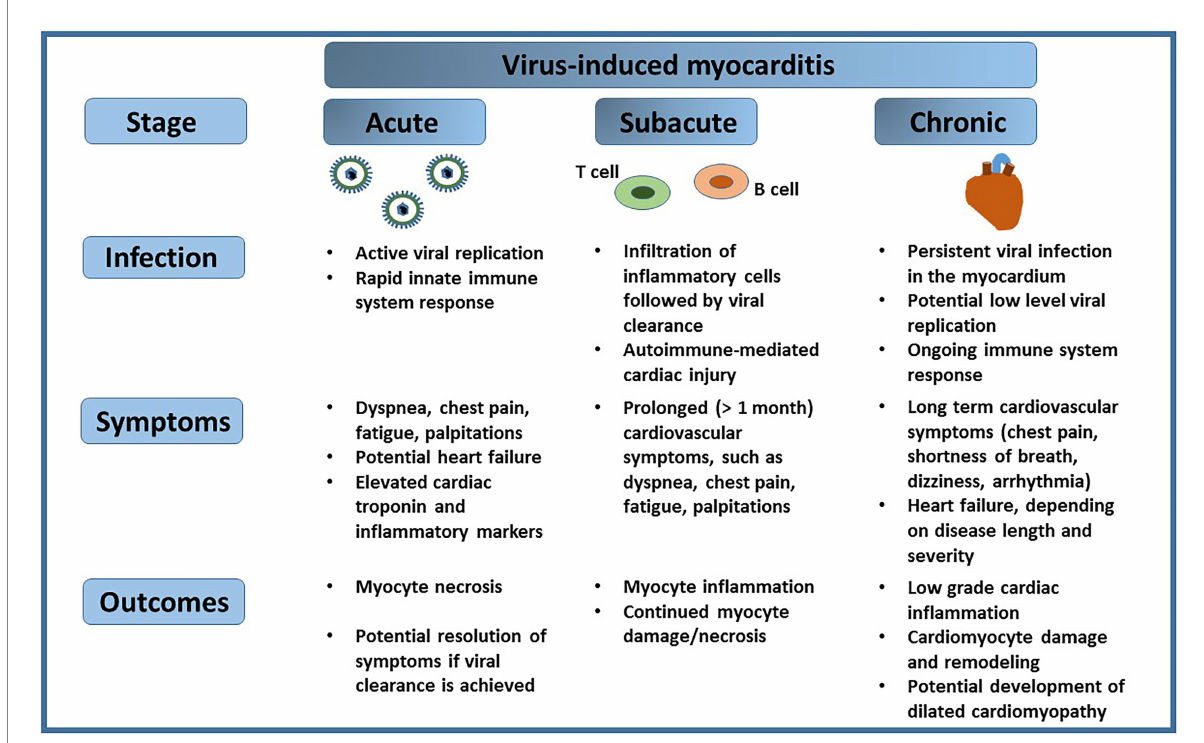
FIGURE 1 Virus-induced myocarditis. A viral infection of the heart can progress from the acute stage, manifested by rapid viral replication, to a chronic stage, which may involve periods of viral reactivation followed by silent infection. Each of the stages of viral infection of the cardiac muscle may present specific symptoms, and result in outcomes that impact cardiovascular